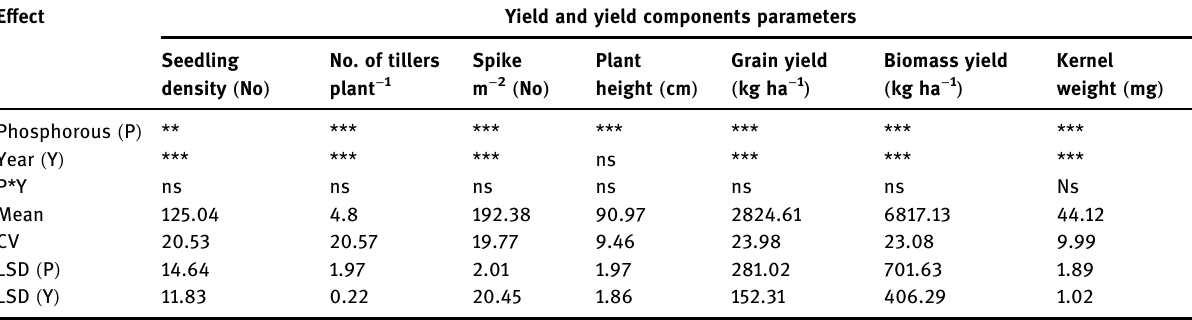
Table 2: ANOVA table for the e ff ects of phosphorous fertilizer rate, year their interaction on the yield and yield components of malting barley across sites E ff